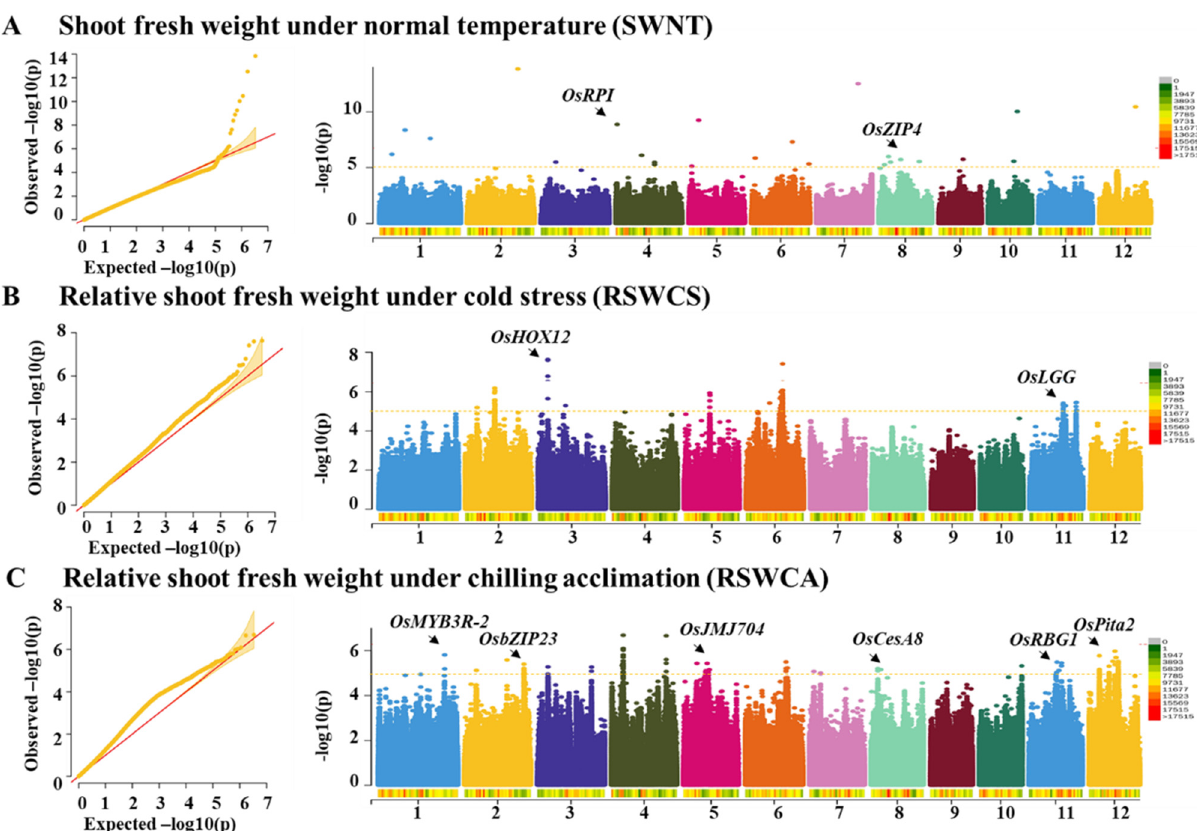
Figure 3. GWAS of the shoot fresh weight under three different conditions. ( A – C ) Manhattan plot of shoot fresh weight under normal temperature (SWNT (g)) ( A ), relative shoot fresh weight under cold stress (RSWCS)( B ), and relative shoot weight under chilling acclimation (RSWCA)( C ). The arrow is linked to significant SNPs that have been reported.